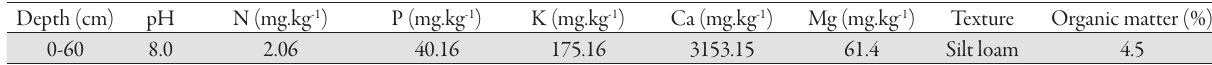
Tab. 1. Physical and chemical characteristics of the soil of experimental field